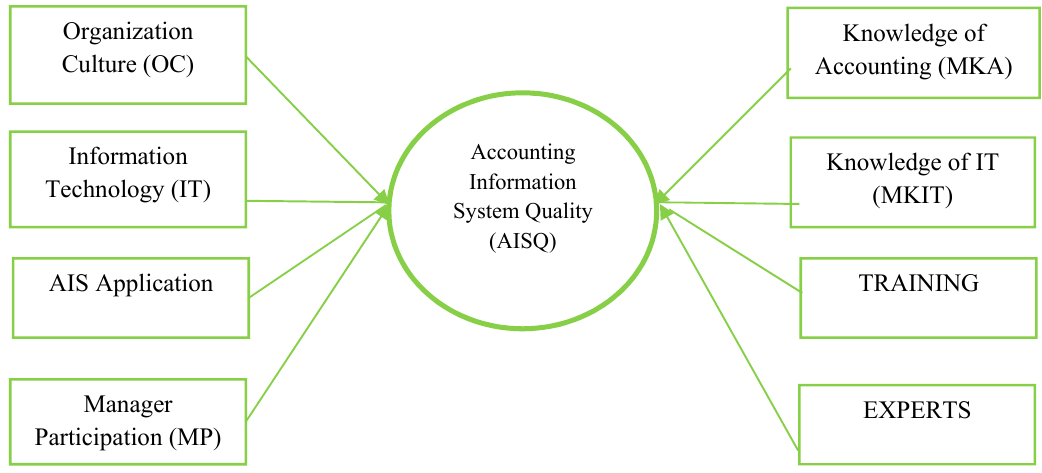
Fig. 1. Accounting information system quality research